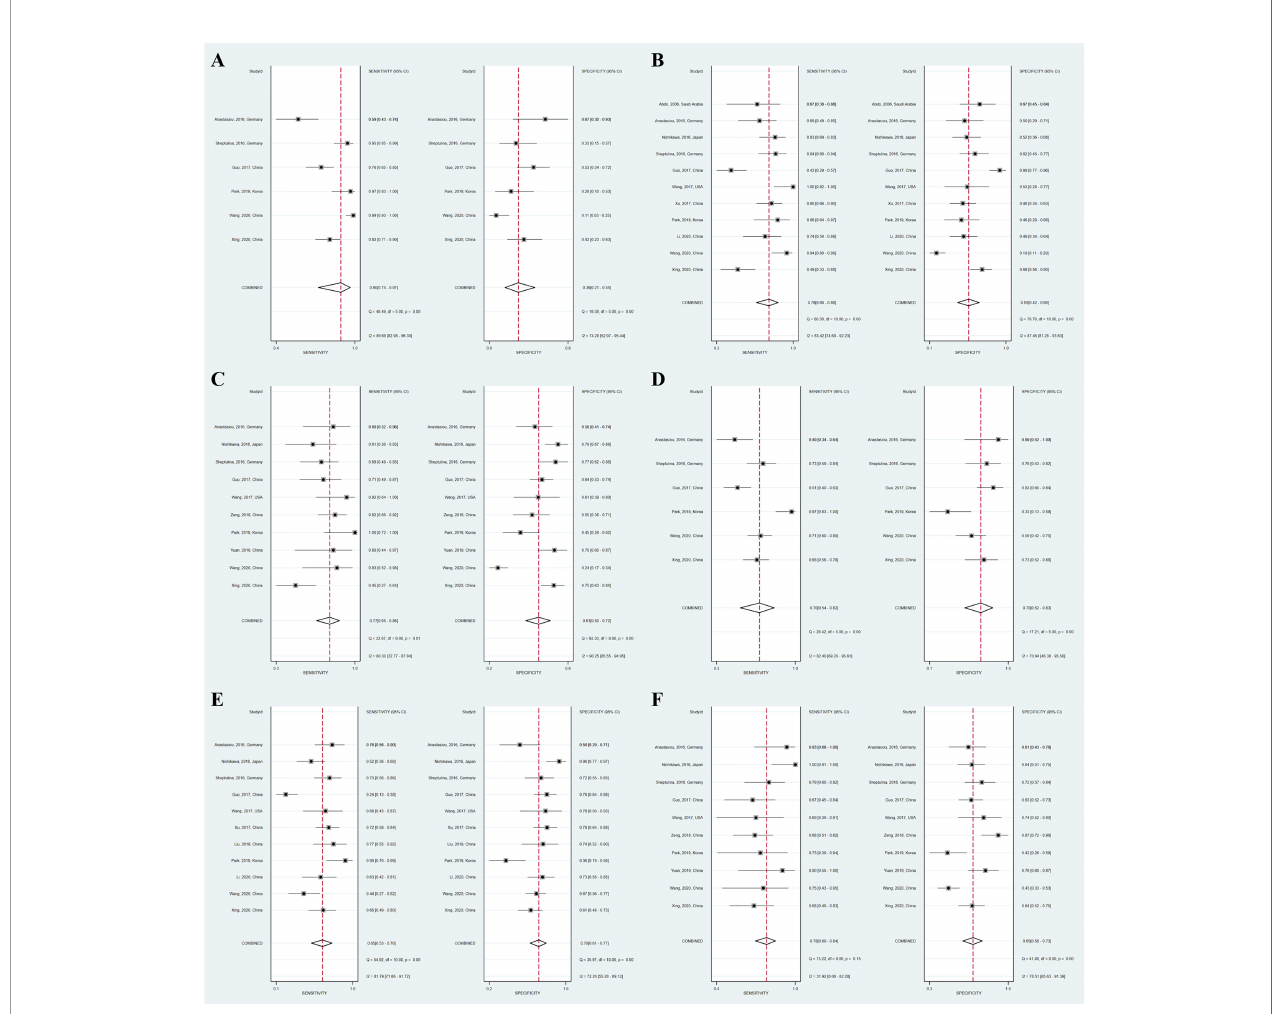
FIGURE 3 | Coupled forest plots of the summary sensitivity and speci fi city of APRI and FIB-4 for the prediction of liver fi brosis in AIH patients. (A) APRI for detecting signi fi cant fi brosis; (B) APRI for detecting advanced fi brosis; (C) APRI for detecting cirrhosis; (D) FIB-4 for detecting signi fi cant fi brosis; (E) FIB-4 for detecting advanced fi brosis; (F) FIB-4 for detecting